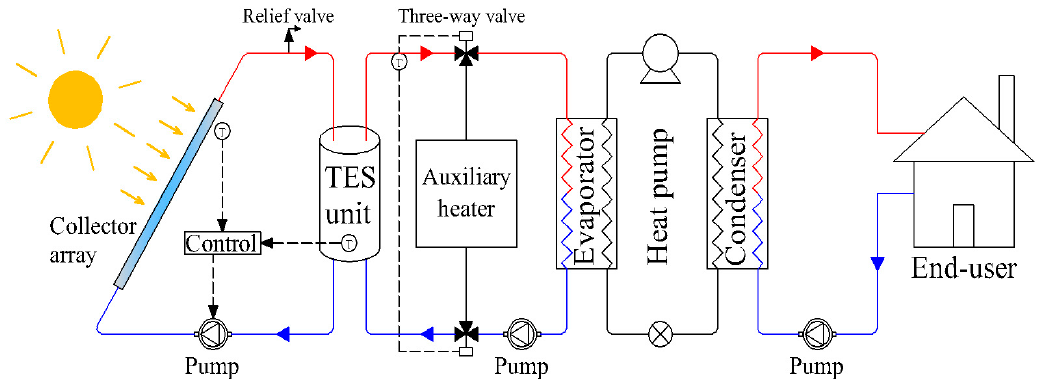
Figure 1. Schematic diagram of a SAHP system using a TES Figure1. Schematic diagram of a SAHP system using a TES unit.